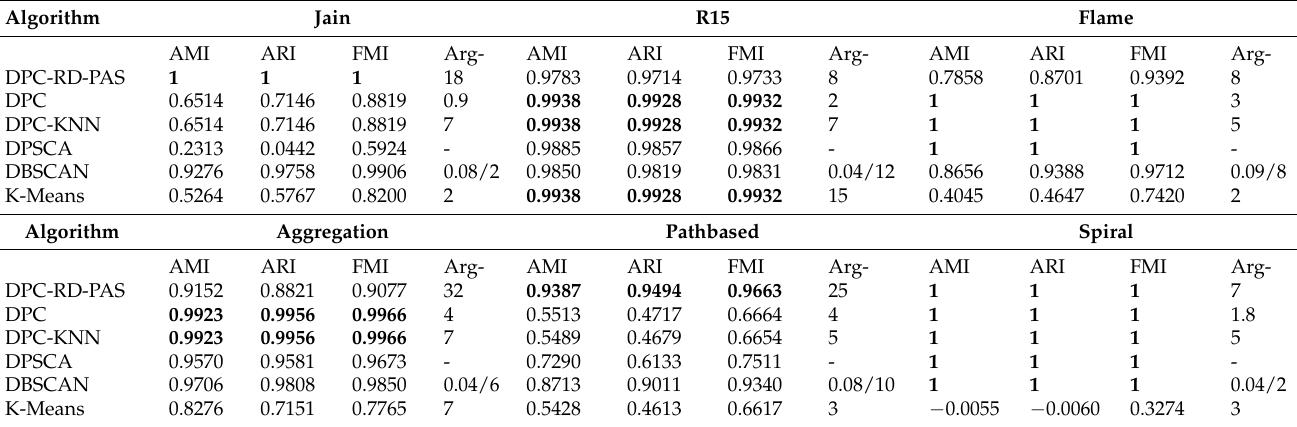
Table 3. Performance on synthetic datasets.